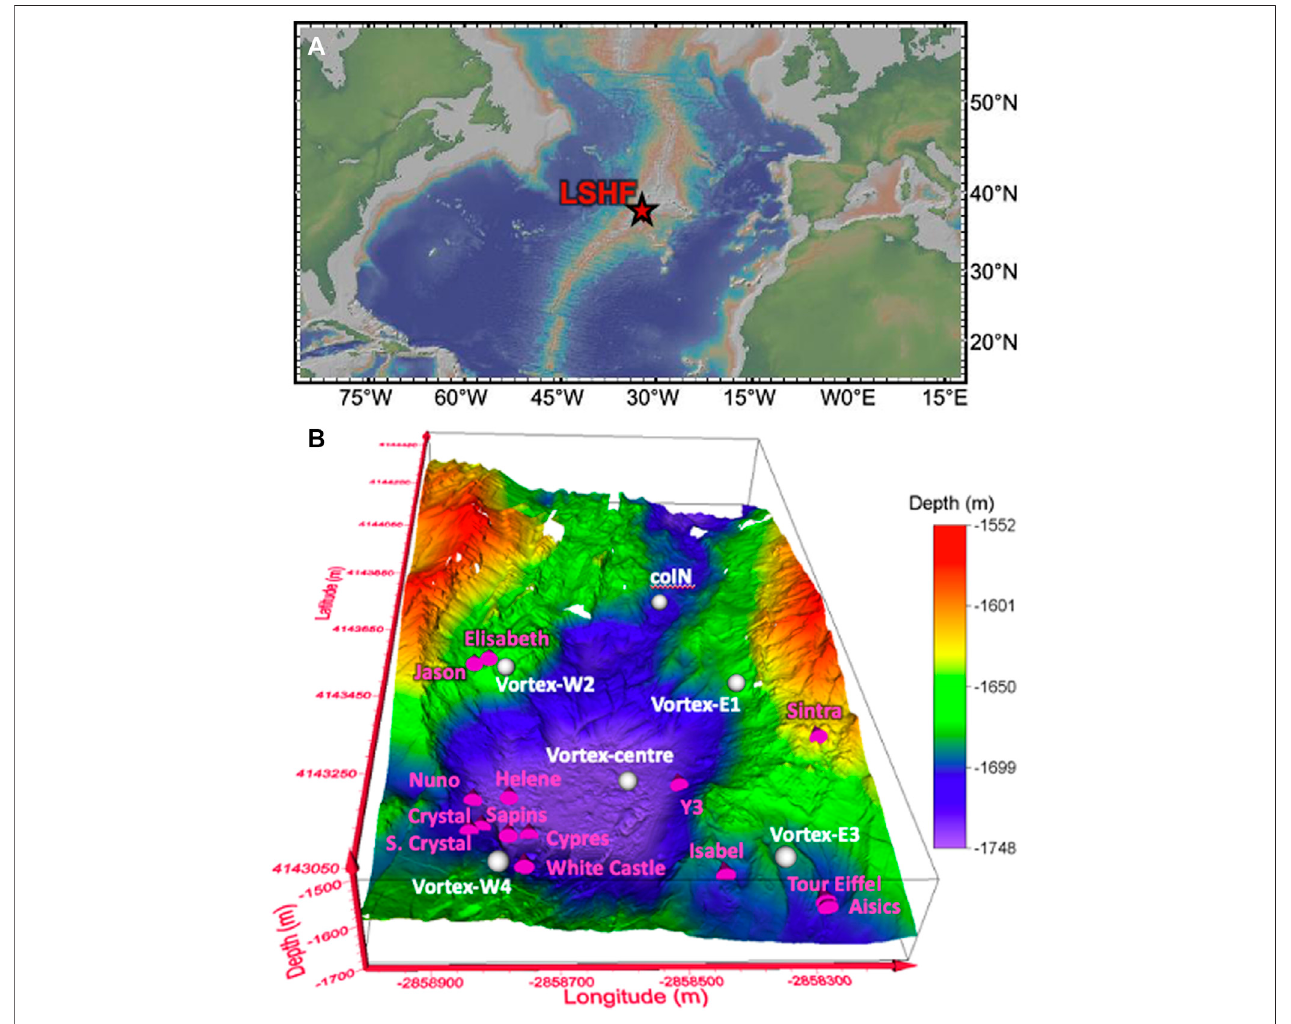
FIGURE 1 | (A) A map of the Lucky Strike Hydrothermal Field (LSHF) location (http://www.geomapapp.org; Ryan et al., 2009), (B) A 3D bathymetric map of the LSHF (Ondréas et al., 2009) where active vent and CTD cast locations are reported as pink 3D cones and white spheres, respectively.